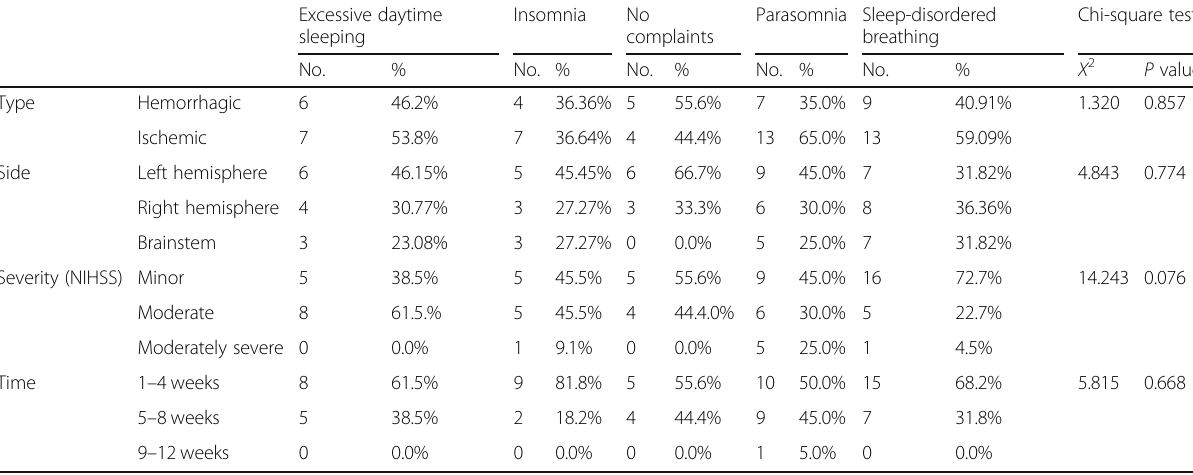
Table 4 Statistical correlations between sleep disorders after stroke and stroke clinical variables